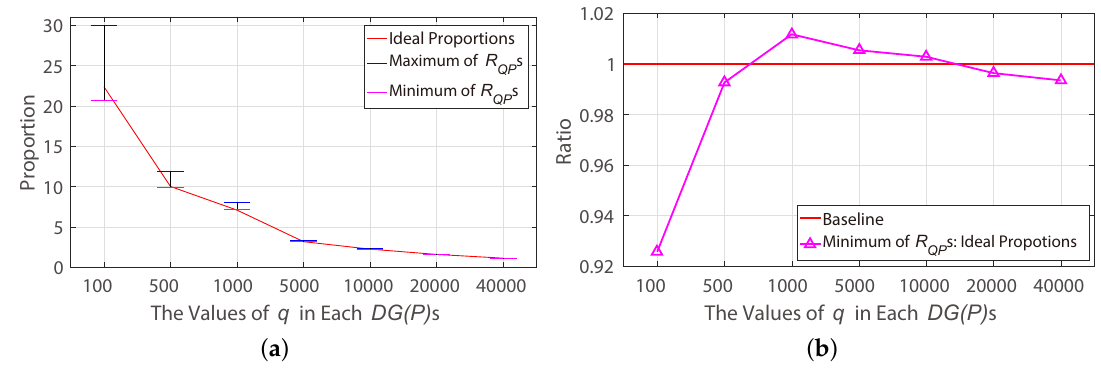
Figure 7. The verified results of the Hypothesis 1. ( a ) The proportion of the maximum and minimum R QP s and ideal proportions. ( b ) The ratios of the minimum R QP s to their corresponding ideal